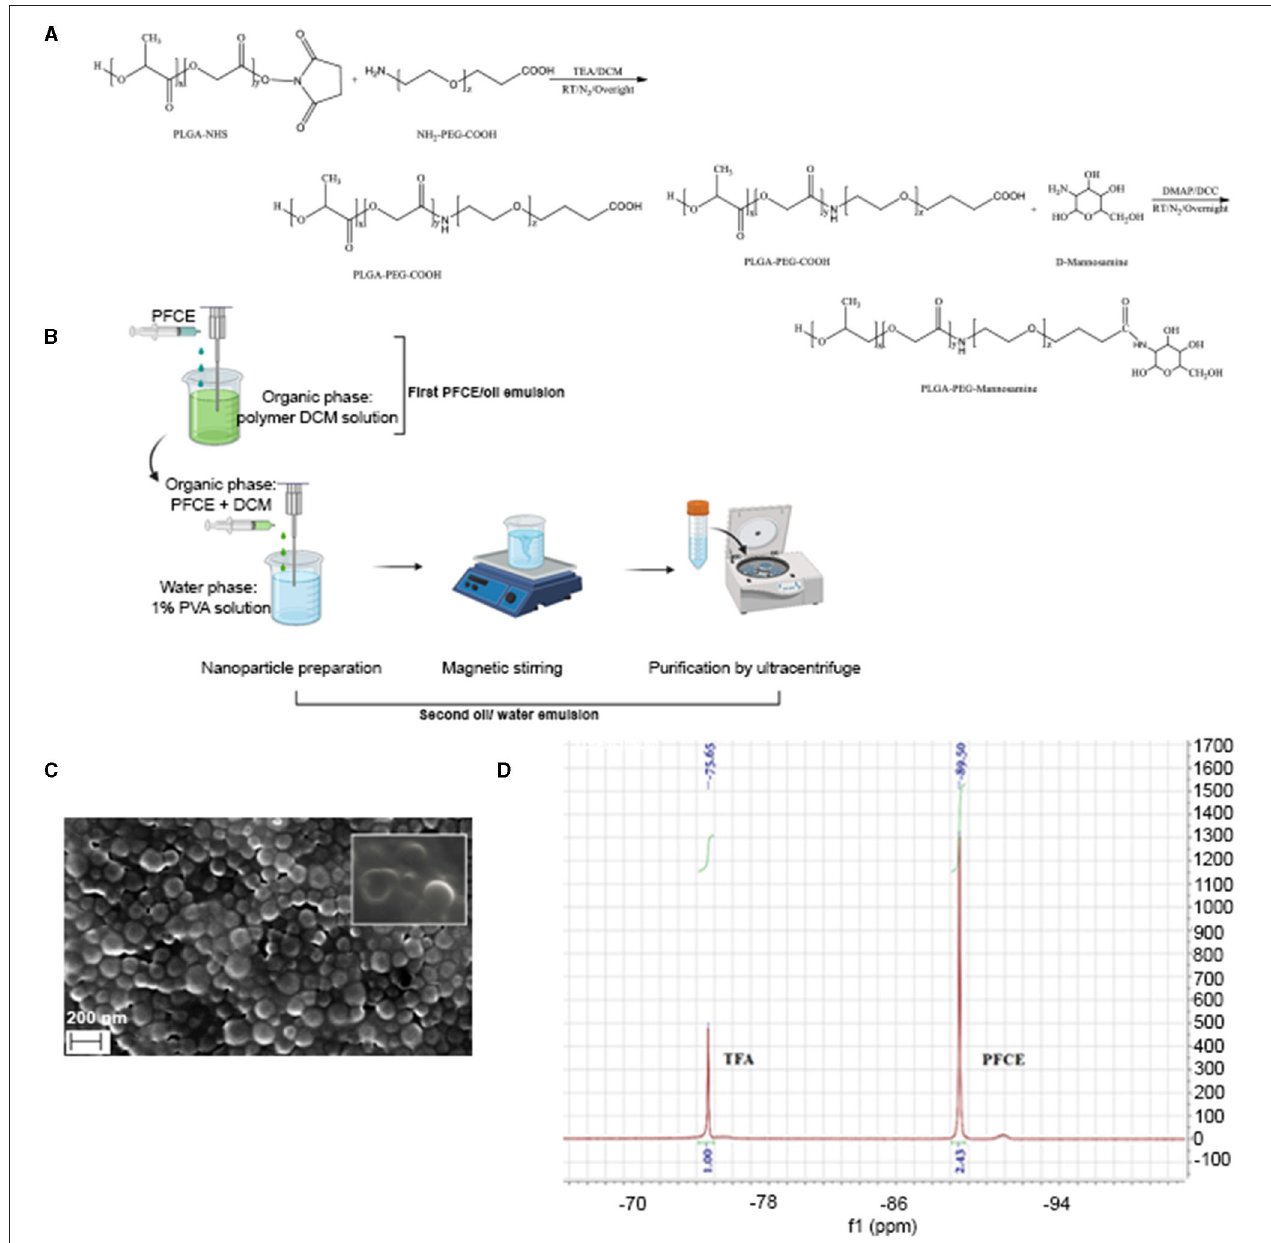
FIGURE 1 | Chemical synthesis and characterization of PLGA-PEG nanoparticles. (A) Illustrative chemical synthesis of PLGA-PEG-COOH and PLGA-PEG-mannose copolymers. (B) Schematic illustration for PFCE/Oil/Water double-emulsion and solvent-evaporation method used to produce PLGA-PEG, PLGA-PEG-mannosamine, or PLGA-PEG-FITC nanoparticles. Scanning Electron Microscopy (SEM) of PLGA-PFCE nanoparticles. (C) Scanning electron microscopy (SEM) image of PFCE encapsulatin PLGA NPs. (D) 19 F-NMR spectrum of PFCE encapsulated PLGA-PEG-FITC-mannose NPs in CDCl3 d in ppm: − 75.65 (3F, CF 3 COOH); − 89.50 (20F, C 10 F 20 O 5 ).